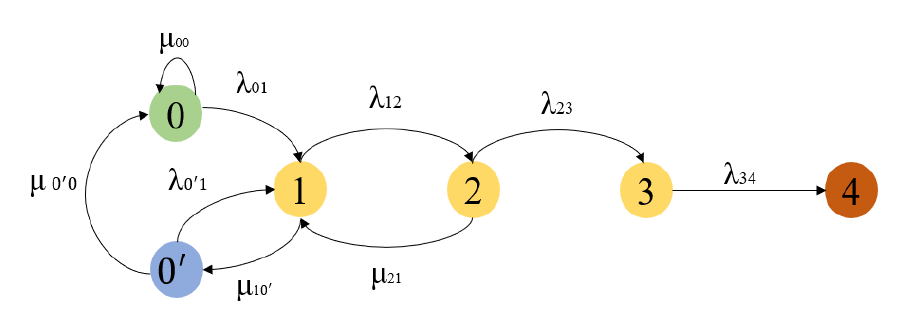
Figure 2. State transition diagram of the bitcoin under the selfish mining